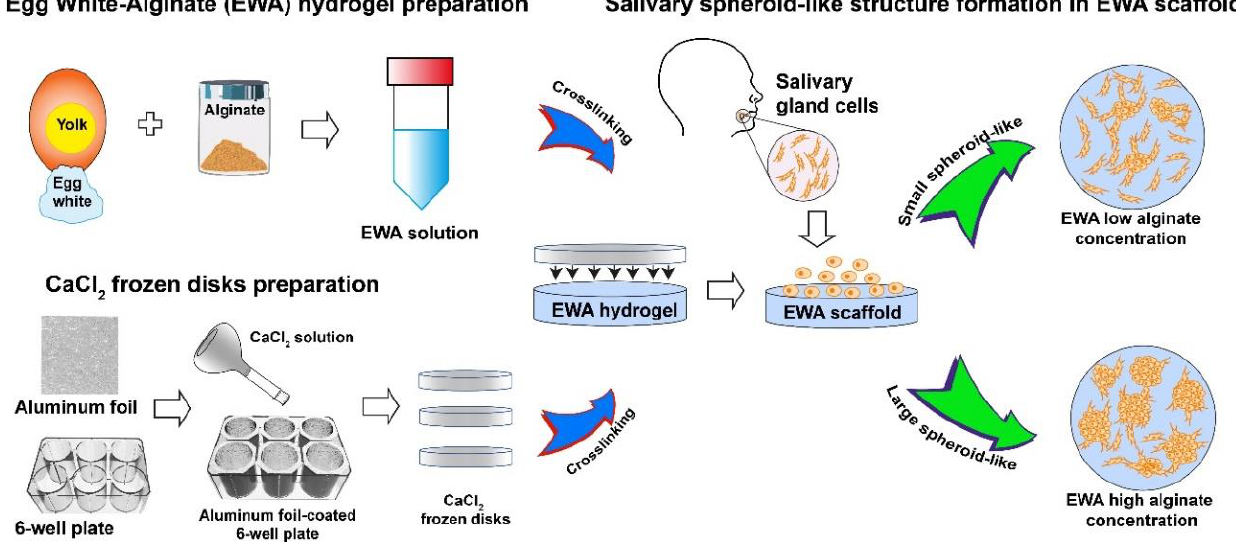
Figure 7. Egg White Alginate (EWA) hydrogel preparation for salivary gland spheroid-like structure formation. EWA is a novel hydrogel which combines the advantages of both egg white and alginate. The egg white material provides extracellular matrix (ECM)-like proteins that can mimic the ECM microenvironment, while alginate can be tuned mechanically through its ionic crosslinking property to modify the scaffold’s porosity, strength, and stiffness. Reprinted from [163] with permission from MDPI.